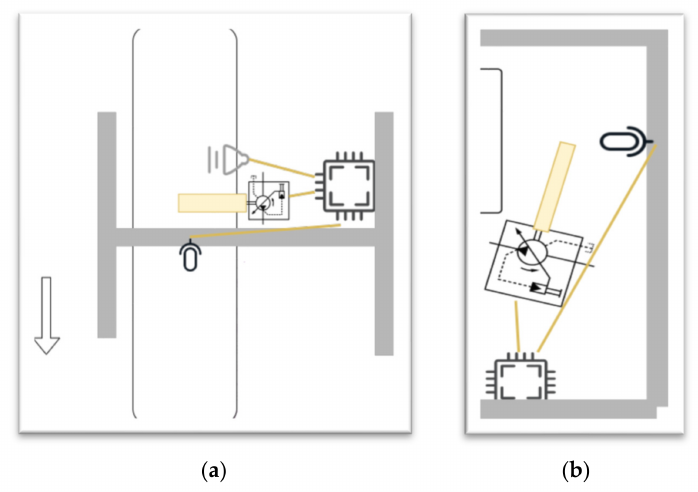
Figure 3. System schematic diagram: ( a ) top view, ( b ) side